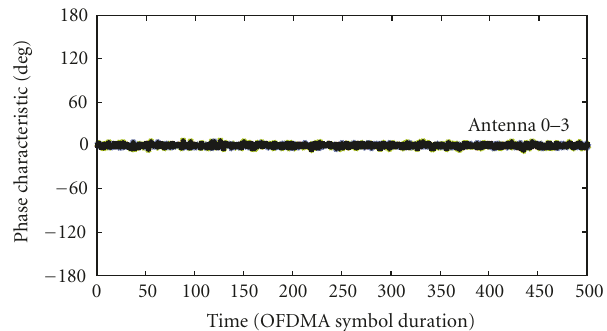
Figure 13: Phase characteristics obtained by experiment after calibration.